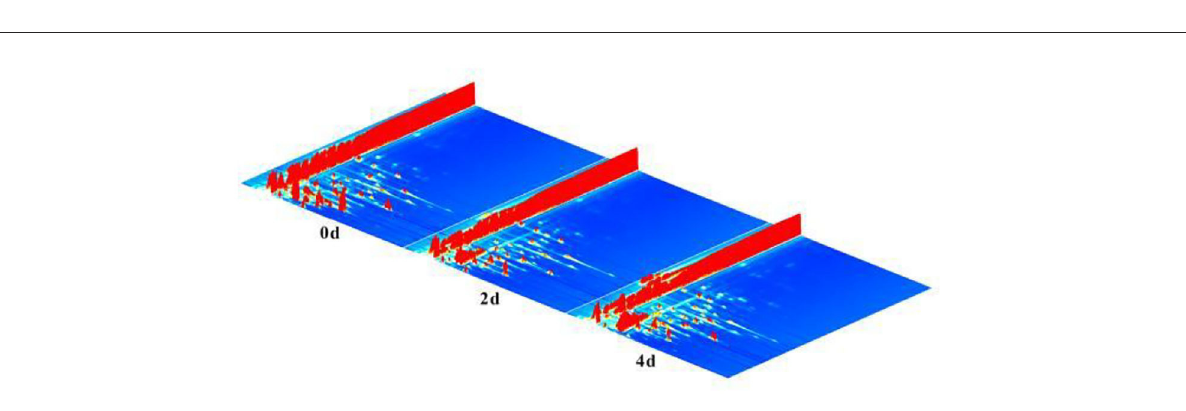
FIGURE2 Three-dimensional (3D) topographic plot of